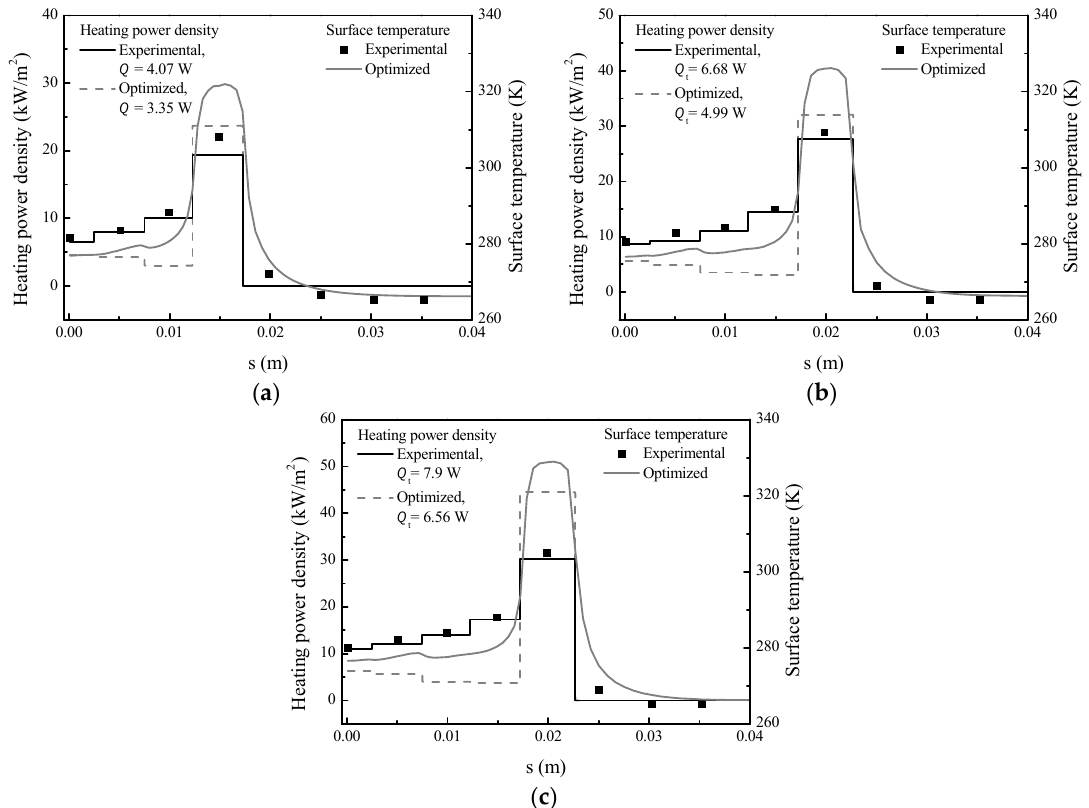
Figure 13. Comparison of the optimized and experimental results: ( a ) Case 1; ( b ) Case 2; ( c ) Case 3.